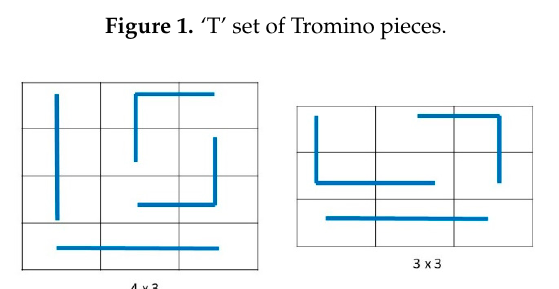
Figure 2. Tiling a ‘a × b’ rectangle with I- & L-Trominoes.